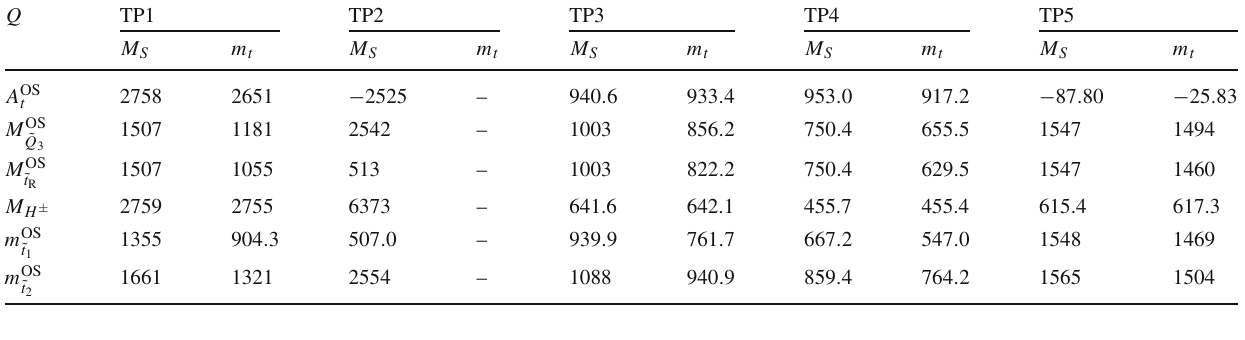
Table 3 OS parameters in the TP scenarios obtained by the routines of NMSSMCALC . Here A OS t is the trilinear soft-breaking parameter in the stop sector, while M OS ˜ and M OS ˜ are the soft SUSY-breaking mass t R Q 3 parametersinthestopsectorforthe SU ( 2 ) L doubletandsinglet,respec-